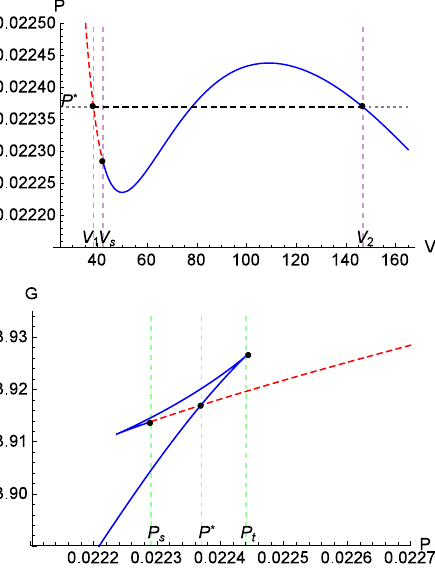
Fig. 4 P − V diagrams (Eqs. (3.14) and (2.13)) and the corresponding Gibbs free energy (Eq. (3.15)) at q = 2 and e = 1 . 5. Left The tempera- ture takes the value of T = 0 . 14000. For the isobar P ∗ = 0 . 02311, V s , V 1 , and V 2 correspond to r s = 1 . 70998, r 1 = 1 . 73921, and